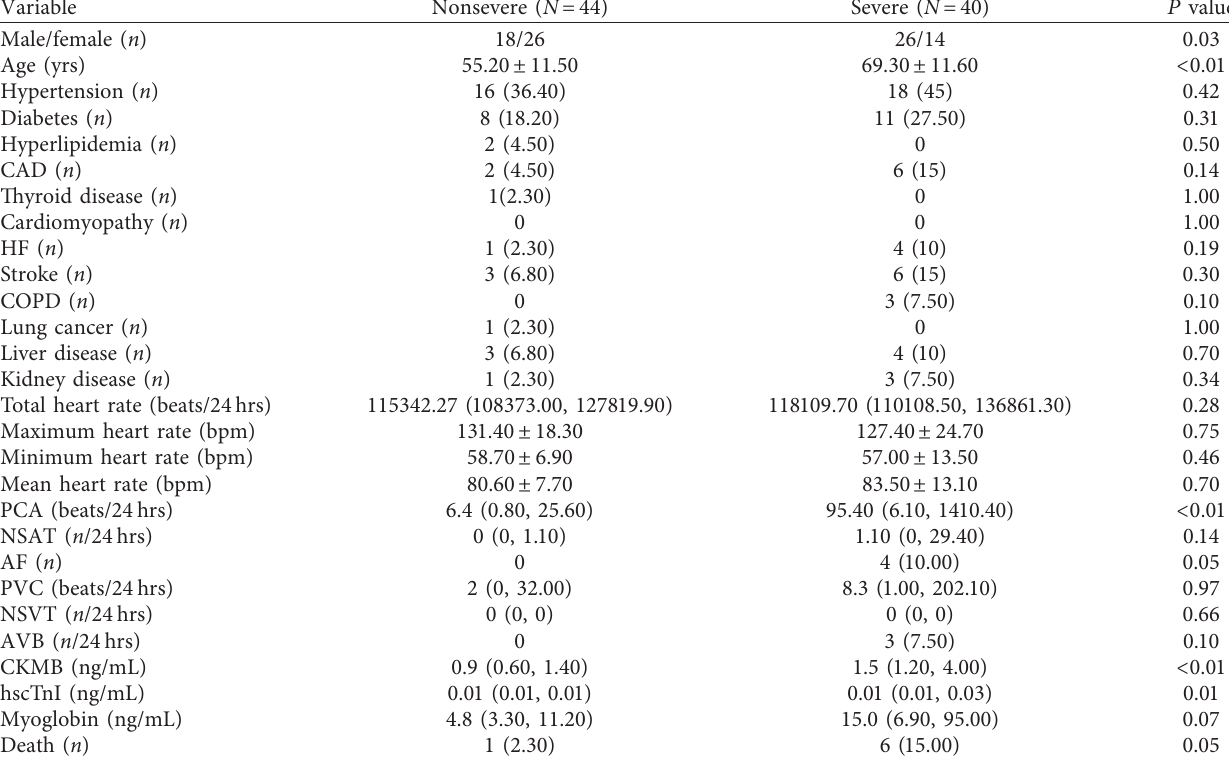
Table 3: Arrhythmias, cardiomyocyte injury markers, and death between nonsevere and severe patients with COVID-19. Variable